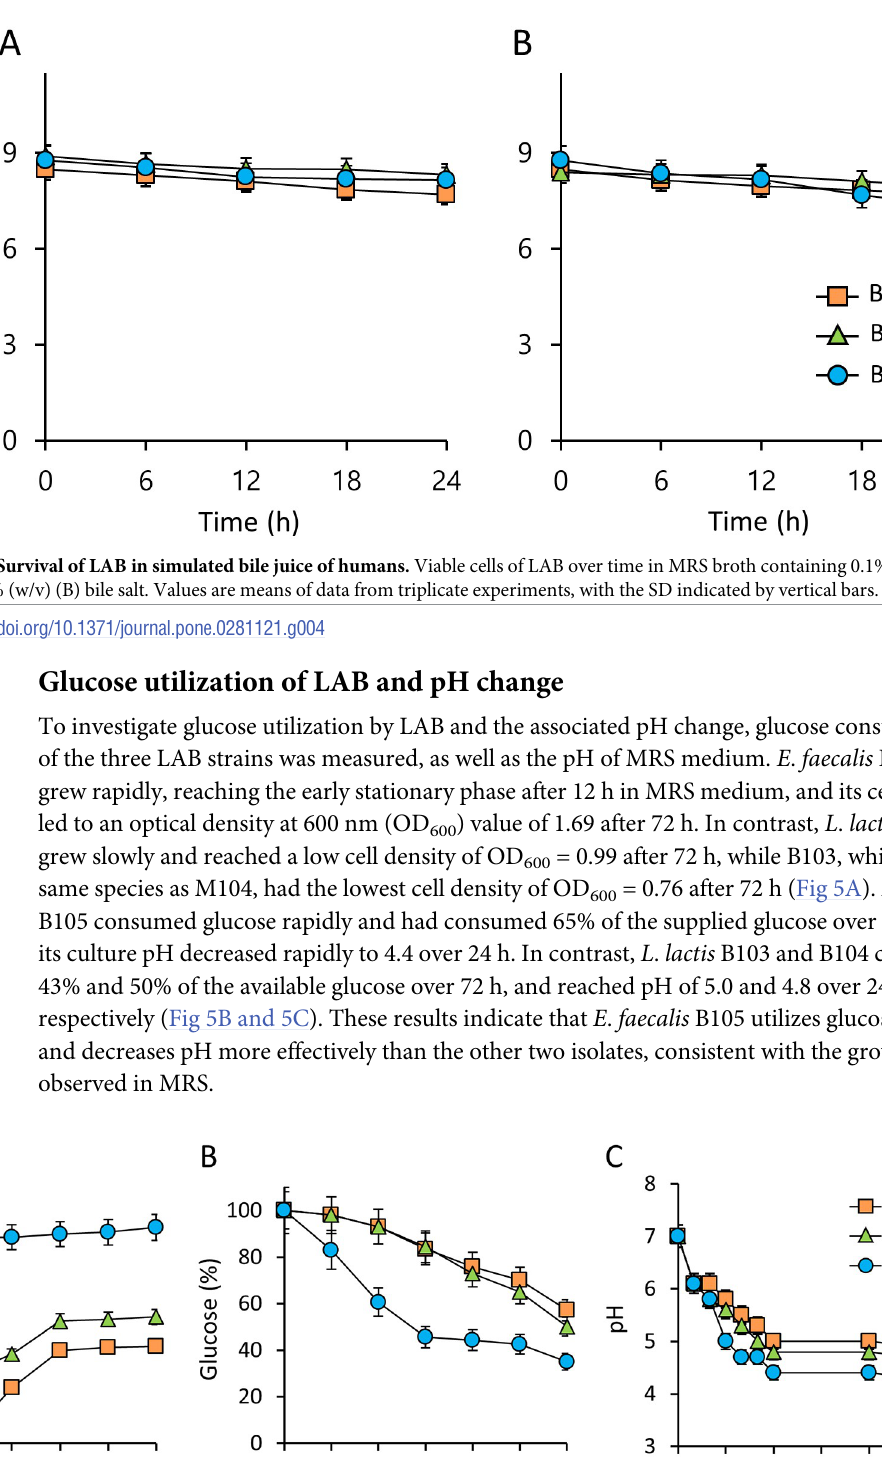
PLOS ONE | https://doi.org/10.1371/journal.pone.0281121 March 30,